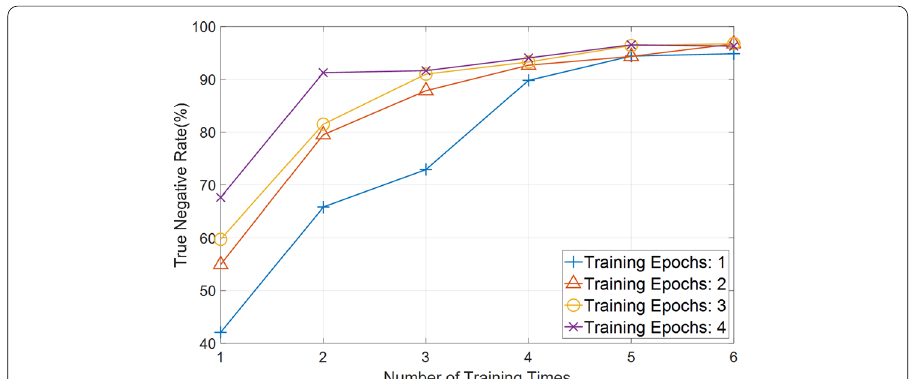
Fig. 16 Relationship between accuracy and training times (True Negative Rate). The relationship between accuracy and the number of training times for rogue devices is depicted in this figure with different training epochs